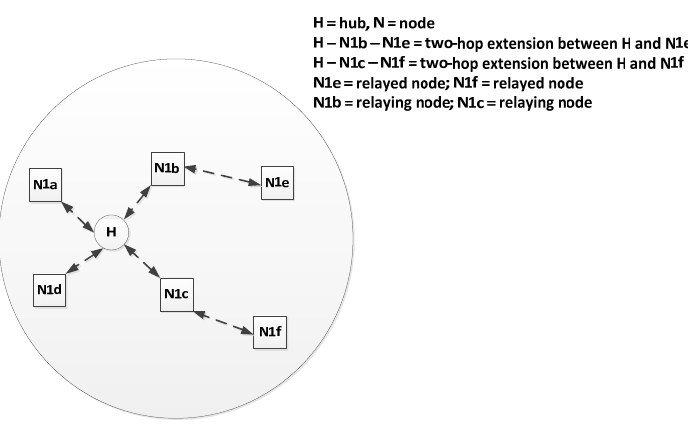
Figure 14. Network Topology (Two-Hop Extended Star)